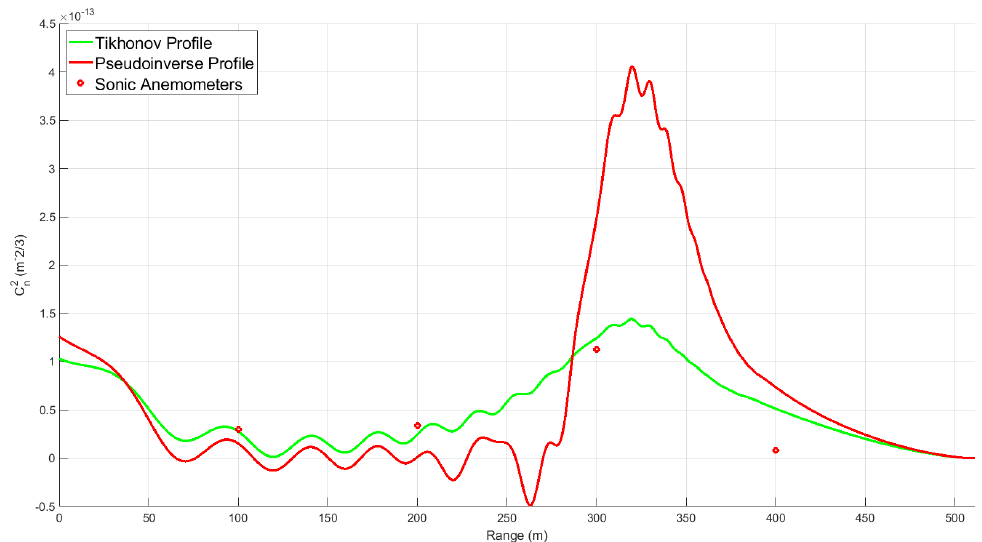
Figure 10. 25 July 22:47 UTC turbulence profile with α = 90. At this time, the BLS measured a C 2 n of 5.4 × 10 − 14 m − 2/3